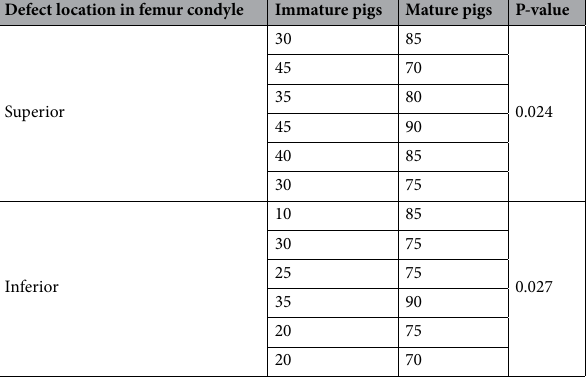
Defect location in femur